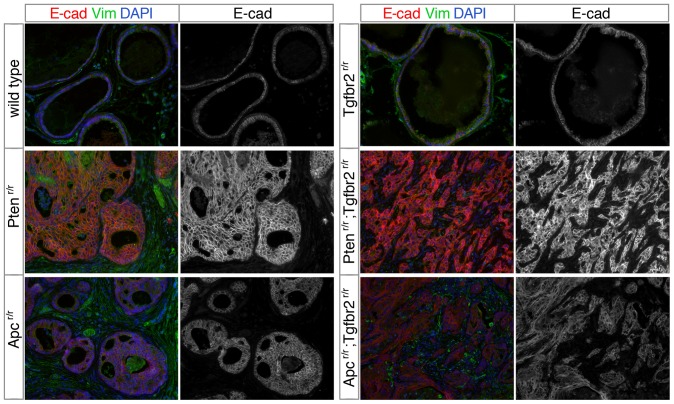
Expression of vimentin and E-cadherin in prostate.Prostates of the indicated genotypes, selected to be representative of the most common phenotype of each, were analyzed by indirect immunofluorescence for E-cadherin (red) and Vimentin (green). Ages are as follows, wild type: 21 weeks, Ptenr/r: 45 weeks, Apcr/r: 52 weeks, Tgfbr2r/r: 70 weeks, Ptenr/r;Tgfbr2r/r: 12 weeks, and Apcr/r;Tgfbr2r/r: 23 weeks.